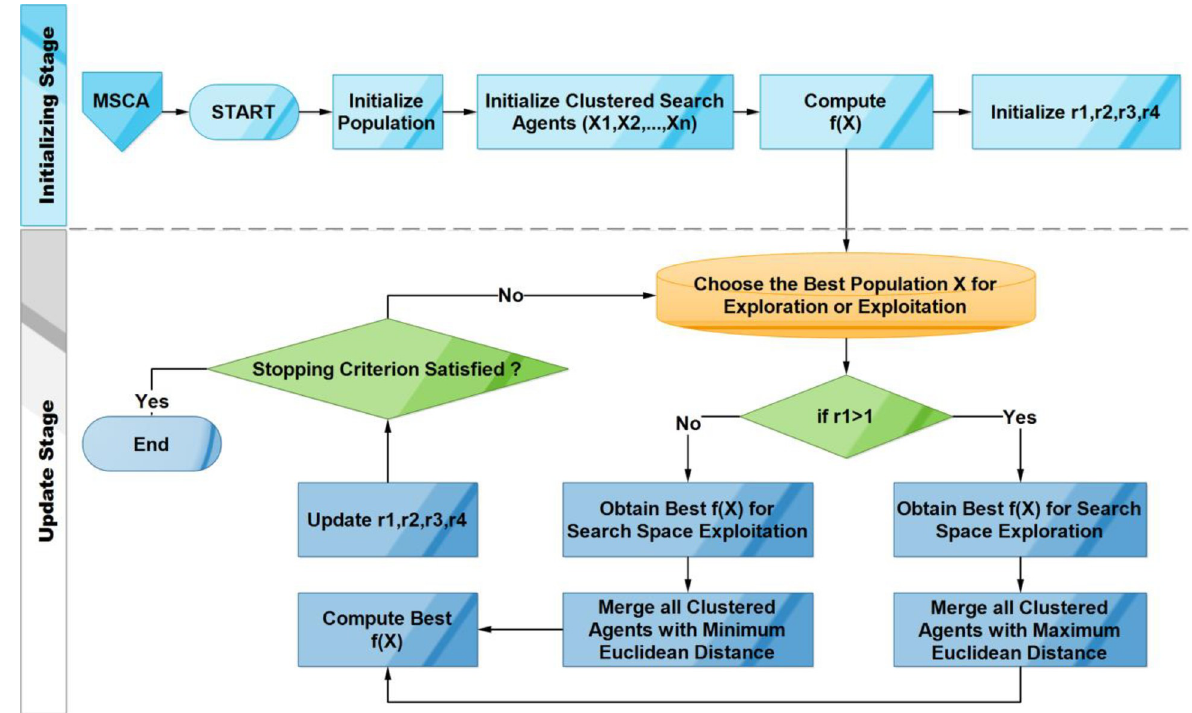
PLOS ONE | https://doi.org/10.1371/journal.pone.0255269 August 6,